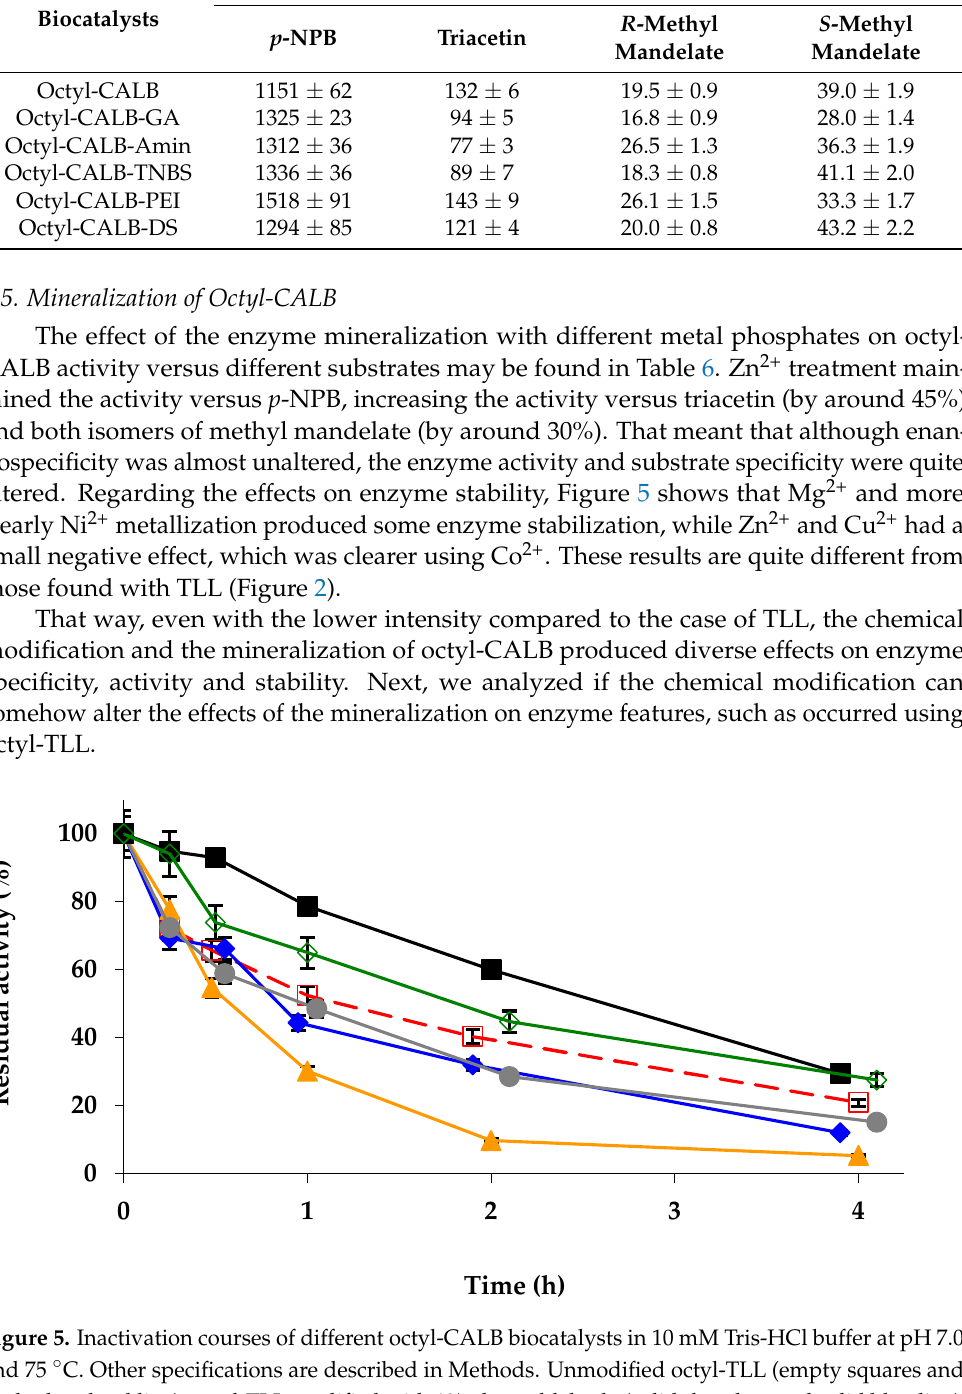
Table 6. Specific activity of different CALB biocatalysts with 1 mM p -NPB (pH 7 and 25 °C), 50 mM triacetin (pH 7 and 25 °C), and 50 mM R - or S -methyl mandelate (pH 7 and 25 °C). Experiments were conducted as described in Methods.